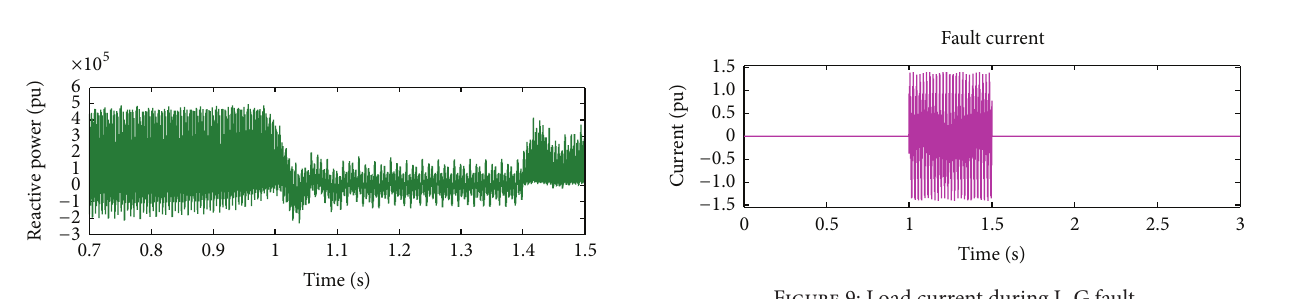
Figure 7: Reactive power during L-G fault.